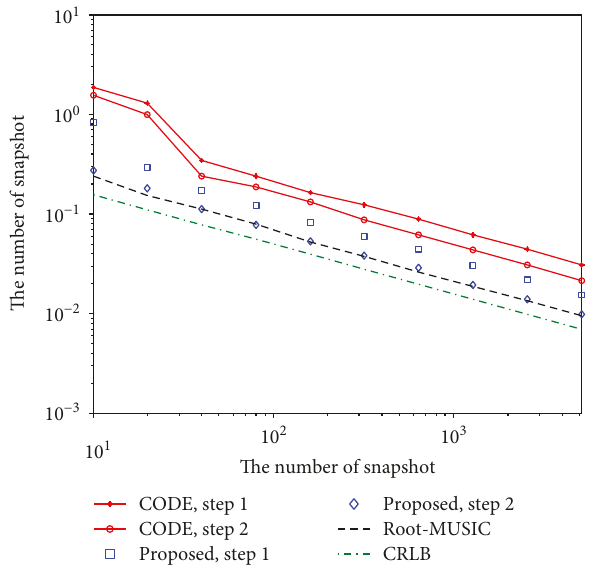
Figure 4: RMSE for θ 5dB , 2 sources at θ N = 5 , γ = 0 5 .